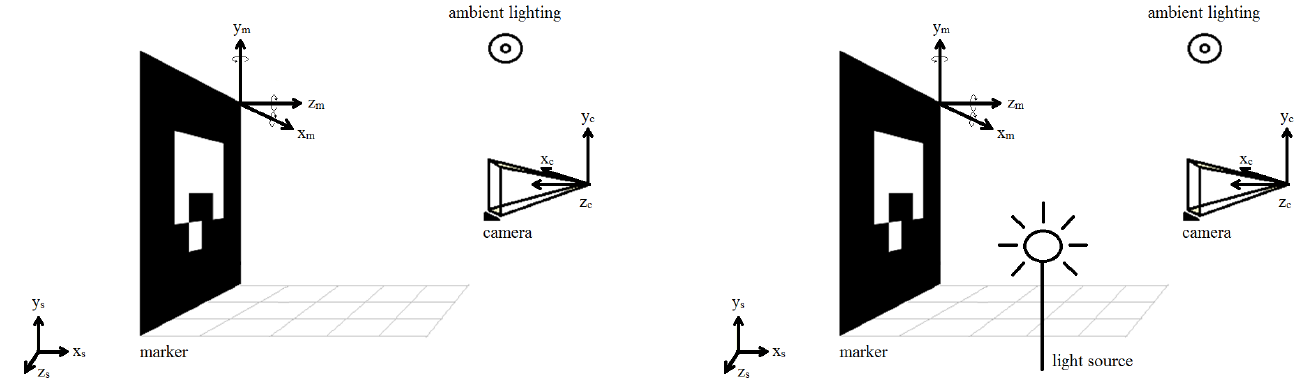
Fig. 3. Scenes of investigation in virtual environment.